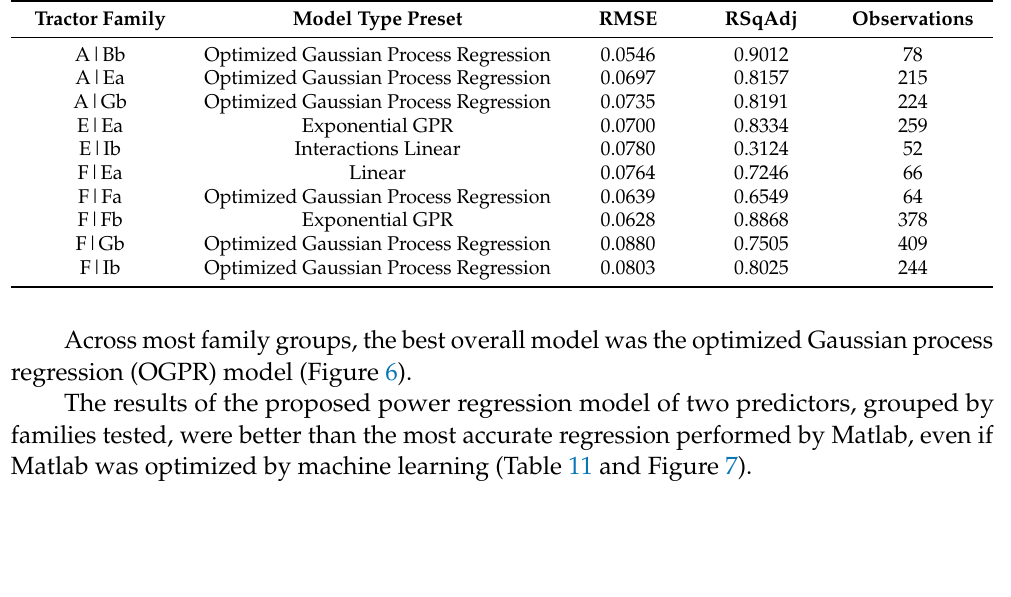
Table 10. RMSE values of the results of two predictors, grouped by families evaluated. Tractor Family